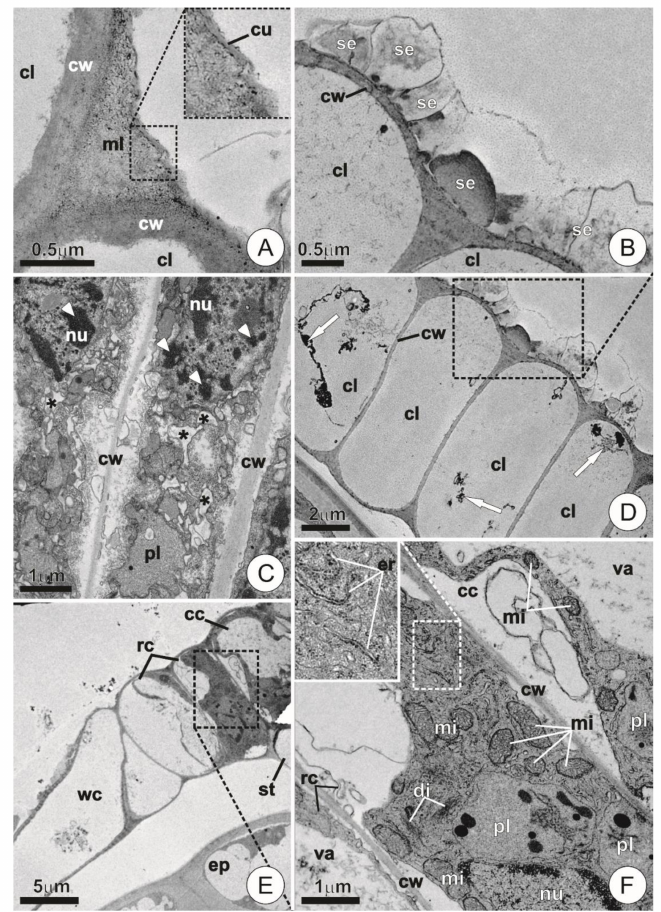
Figure 5. Ultrastructure of the wing and central disc cells in mature trichomes. ( A ) Detail of the region between adjacent cells showing conspicuous walls. Note the indistinct and discontinuous cuticle. ( B ) Detail showing secretion of fibrillar and compact aspect on the surface of mature wing cells. ( C ) Degenerating wing cells showing chromatin condensation / fragmentation (arrowheads) and the occurrence of vesiculation throughout the cytoplasm (asterisks). ( D ) Cross-section of the wing showing cells with empty lumens and residues of cytoplasm (arrows). ( E ) Overview of the shield in cross-section. Note the extravacuolar cytoplasm restricted to the periphery of the outer ring and central cells. ( F ) Detail of the dotted area in E showing protoplast composition. Note abundant mitochondria, plastids, and endoplasmic reticulum. (cc = central cell; cu = cuticle; cl = cell lumem; cw = cell wall; di = dictyosomes; ep = ordinary epidermis cell; er = endoplasmic reticulum; mi = mitochondria; ml = middle lamella; nu = nucleus; pl = plastids; rc = ring cell; se = secretion; st = stalk; va = vacuole; wc = wing